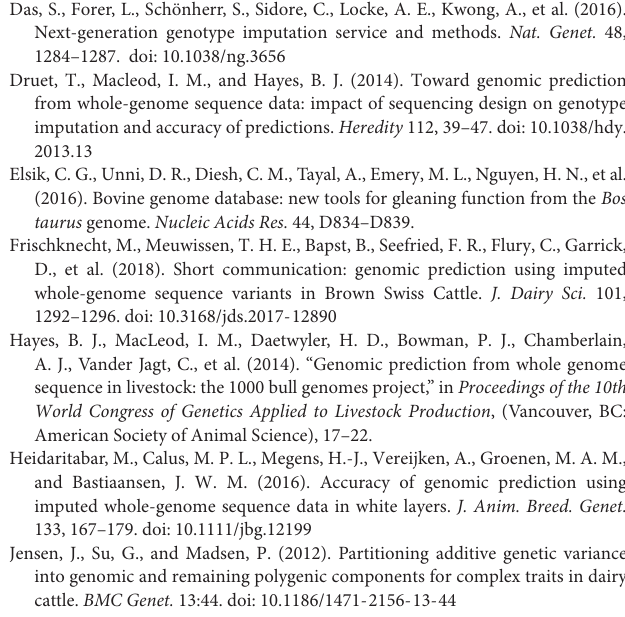
Supplementary Figure 1 | Venn diagram of 1,000 (A) , 3,000 (B) , 5,000 (C) , and 10,000 (D) pre-selected variants from WGS overlapping between traits. Backfat thickness (BFT), carcass weight (CWT), longissimus muscle area (LMA), and marbling score (MS). Supplementary Figure 2A | Manhattan plot of genome-wide association study (GWAS) using different set of SNPs for backfat thickness (BFT) pre-selected variants from entire whole-genome sequence data overlapping between traits. Whole-genome sequence (WGS), intergenic (IGR), intron (ITR), regulatory (REG), synonymous (SYN), non-synonymous (NSY), and combination of regulatory, synonymous and non-synonymous (RSN). Supplementary Figure 2B | Manhattan plot of genome-wide association study (GWAS) using different set of SNPs for carcass weight (CWT) pre-selected variants from entire whole-genome sequence data overlapping between traits. Whole-genome sequence (WGS), intergenic (IGR), intron (ITR), regulatory (REG), synonymous (SYN), non-synonymous (NSY), and combination of regulatory, synonymous and non-synonymous (RSN). Supplementary Figure 2C | Manhattan plot of genome-wide association study (GWAS) using different set of SNPs for longissimus muscle area (LMA) pre-selected variants from entire whole-genome sequence data overlapping between traits. Whole-genome sequence (WGS), intergenic (IGR), intron (ITR), regulatory (REG), synonymous (SYN), non-synonymous (NSY), and combination of regulatory, synonymous and non-synonymous (RSN). Supplementary Figure 2D | Manhattan plot of genome-wide association study (GWAS) using different set of SNPs for marbling score (MS) pre-selected variants from entire whole-genome sequence data overlapping between traits. Whole-genome sequence (WGS), intergenic (IGR), intron (ITR), regulatory (REG), synonymous (SYN), non-synonymous (NSY), and combination of regulatory, synonymous and non-synonymous (RSN). Supplementary Table 1 | Number of singleton animals based on different GRM relatedness